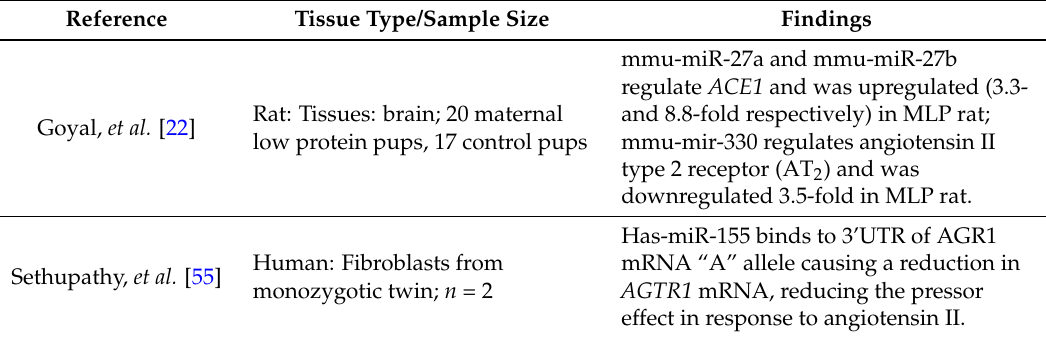
Table 3. Summary of non-coding RNAs in relation to